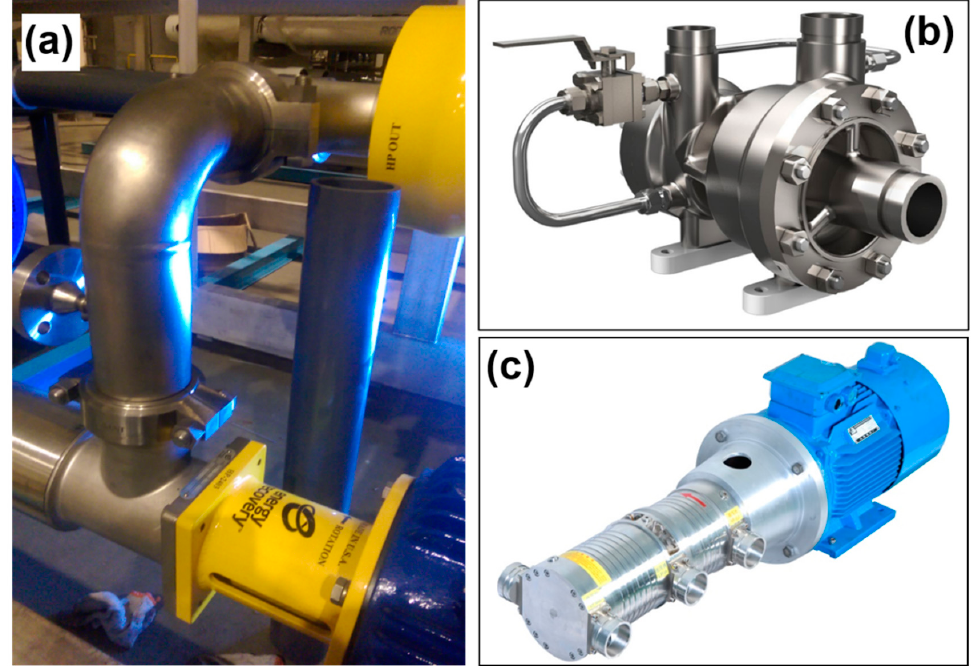
Figure 11. Photographs of ( a ) titanium-based pipelines and ( b , c ) high-pressure pumps.